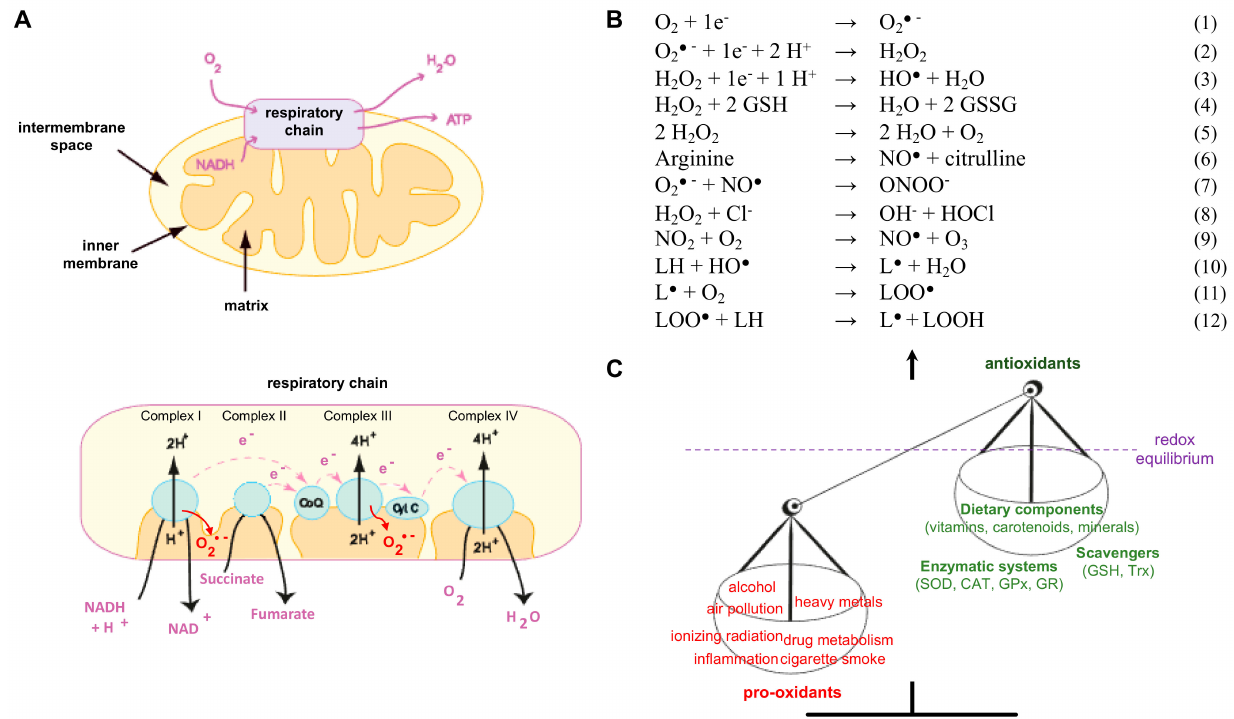
Figure 1. Reactive species production and disruption of the redox homeostasis. ( A ) Generation of superoxide anions (O 2 •− ) by the complexes I and III of the mitochondrial respiratory chain. ( B ) ROS are byproducts of the normal metabolism of oxygen. (1) ROS formation follows the monoelectronic reduction of O 2 . (2) Superoxide dismutases catalyse the dismutation of superoxide into hydrogen peroxide H 2 O 2 . (3) Hydroxyl radical HO • is produced by decomposition of H 2 O 2 via the Fenton reaction (Fe(II)-dependent reaction). (4) Glutathione peroxidase catalyses the reduction of hydrogen peroxide to water via oxidation of reduced glutathione (GSH) into its disulphide form (GSSG). (5) Catalase reacts with the hydrogen peroxide to catalyse the formation of water and O 2 . (6) The production of nitric oxide (NO • ), a reactive nitrogen species, is carried out from L-arginine by nitric oxide synthases. (7) Peroxynitrite ONOO − is produced by the reaction of the free radical superoxide O 2 •− with the free radical nitric oxide NO • . (8) Hypochlorous acid (HOCl) is produced through myeloperoxidase (MPO)-catalysed peroxidation of chloride anions using H 2 O 2 . (9) Nitrogen dioxide (NO 2 ) reacts with molecular oxygen to form, under the action of UV radiation and heat, nitric oxide (NO • ) and ozone (O 3 ). Lipid peroxidation (10)–(12) is a chain of reactions of oxidative degradation of lipids: (10) unsaturated lipid (LH) reacts with prooxidants (hydroxyl radical, HO • ), leading to the formation of lipid radical (L • ) and water; (11) lipid radical then reacts with oxygen to form a lipid peroxy radical (LOO • ), which abstracts one hydrogen from another lipid molecule, generating a new lipid radical (L • ) and lipid hydroperoxide (LOOH) (12). ( C ) The redox balance is an equilibrium between ROS production, due to pro-oxidant conditions, and antioxidant defences. A disruption of this redox balance in favour of oxidative conditions will promote an oxidative stress. CAT, catalase; CoQ, coenzyme Q; Cyt C, cytochrome C; GPx, glutathione peroxidase; GR, glutathione reductase; GSH, reduced glutathione; GSSG, oxidized glutathione; SOD, superoxide dismutases; Trx,